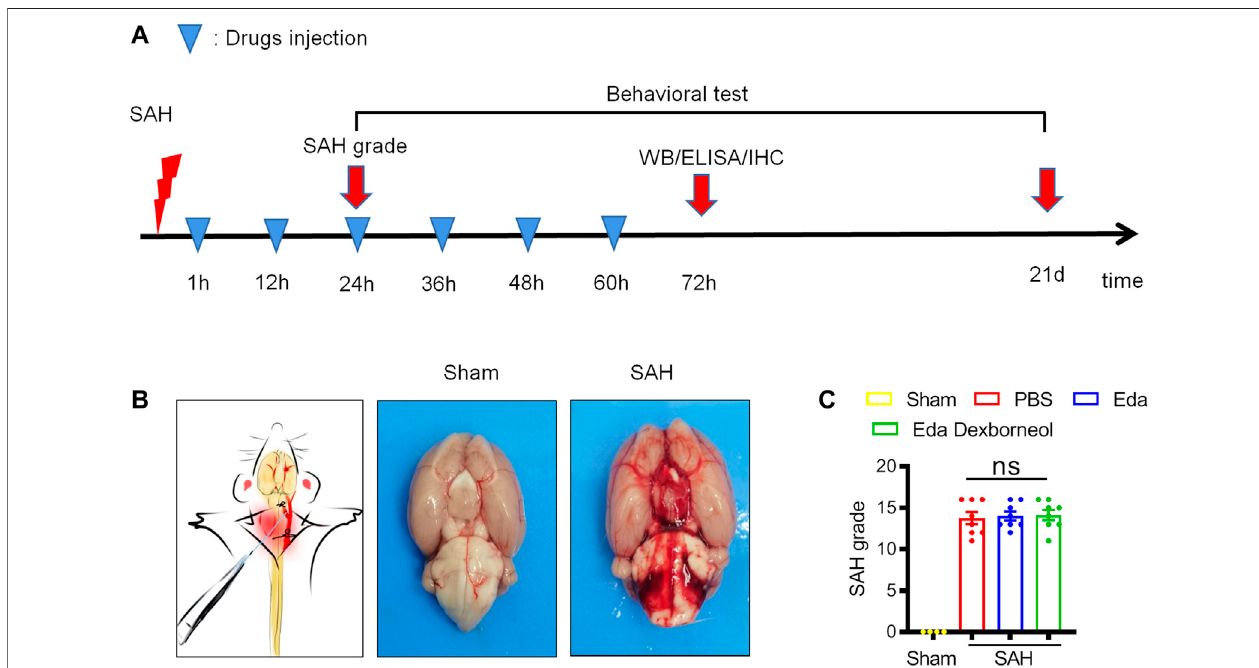
FIGURE1| EstablishmentofastableSAHratmodel. (A) Diagramshowingthetimepointsfordruginjectionandoutcomeevaluation. (B) Schematicrepresentation oftheSAHmodel(left)andrepresentativeimagesofratbrainsinthesham/SAHgroup. (C) SAHgradingscoresofthefourgroupswereassessedafter24h. n =4/group. Data are given as mean ± SE. ns: no signi fi cant difference; Eda: edaravone; Eda dexborneol: edaravone